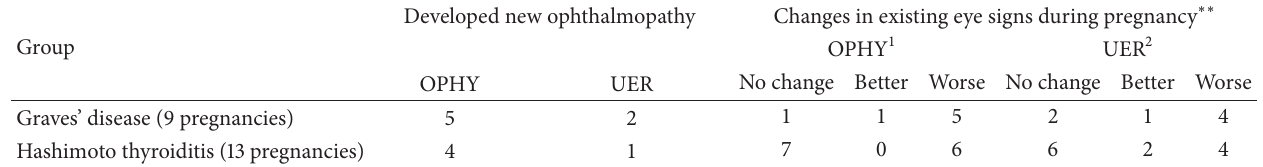
Table 3: Changes in eye signs in the postpartum period in patients with Graves hyperthyroidism and Hashimoto thyroiditis. Eye changes in the postpartum period ∗∗ Group Ophthalmopathy Upper eyelid retraction No change 1 Better Worse No change Better Worse Graves hyperthyroidism ( 𝑛 = 9 pregnancies) 2 3 2 4 0 3 5 3 1 5 4